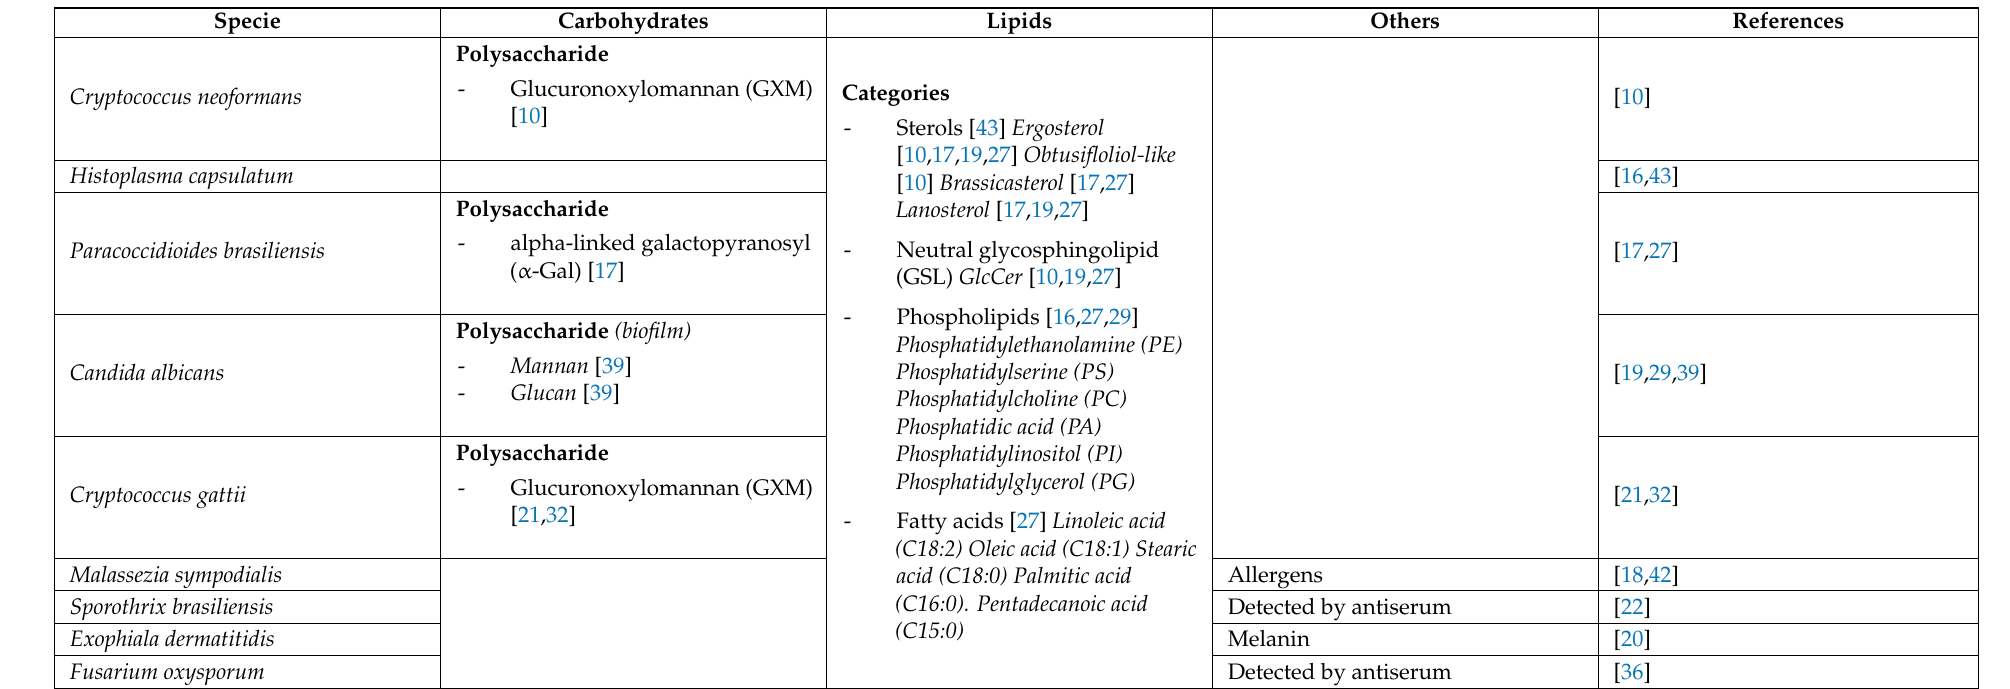
Table 2. Kingdom specific component of fungal